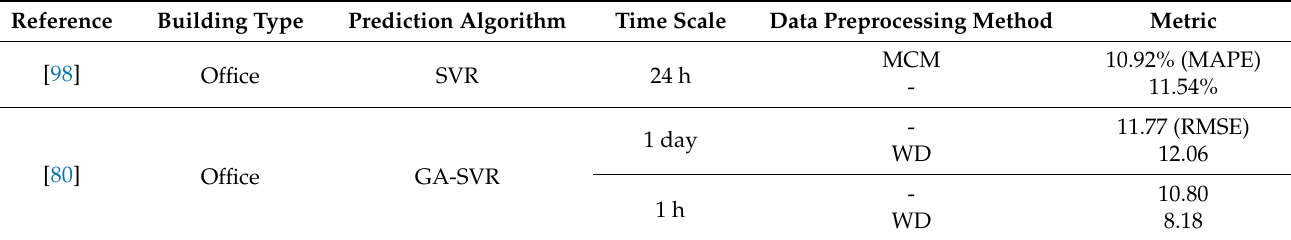
Table 2. Accuracy comparison of different data preprocessing